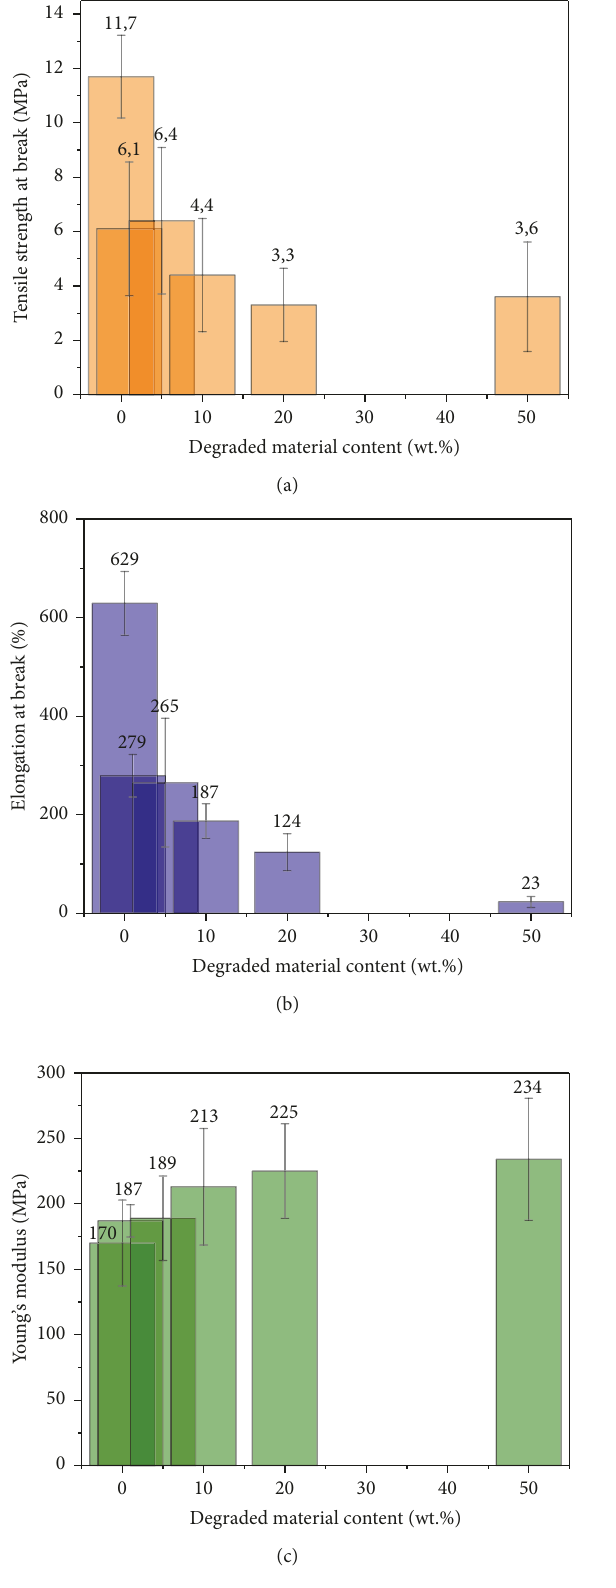
Figure 6: Effect of the degraded LDPE incorporation on the properties of degraded material/LDPE blend: (a) tensile strength at break, (b) elongation at break, and (c) Young’s modulus.